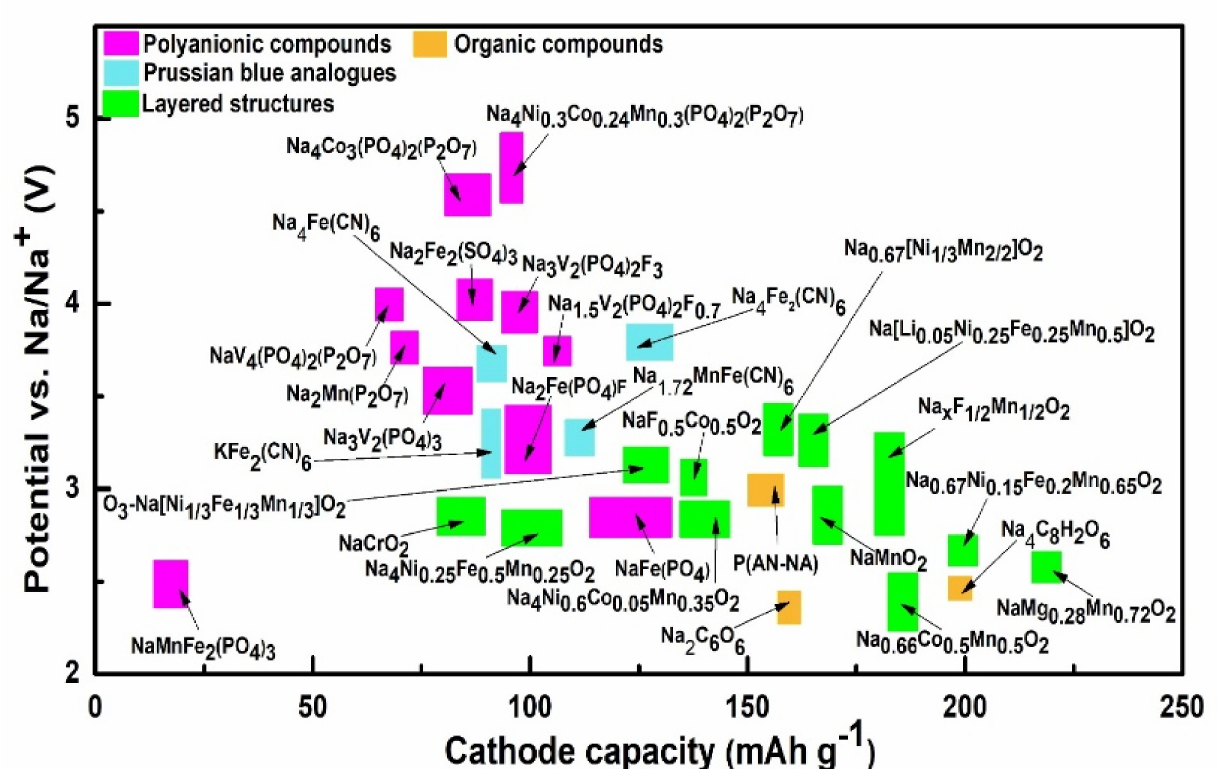
Figure 12. Specific capacities of cathode materials used in Na-based batteries.